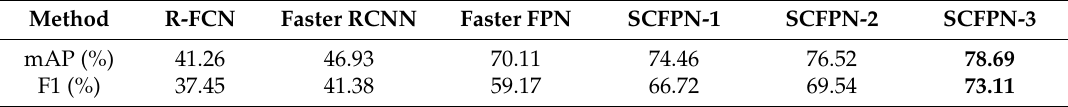
Table 6. Comparison of the cross-validation results. The bold results are the best performance